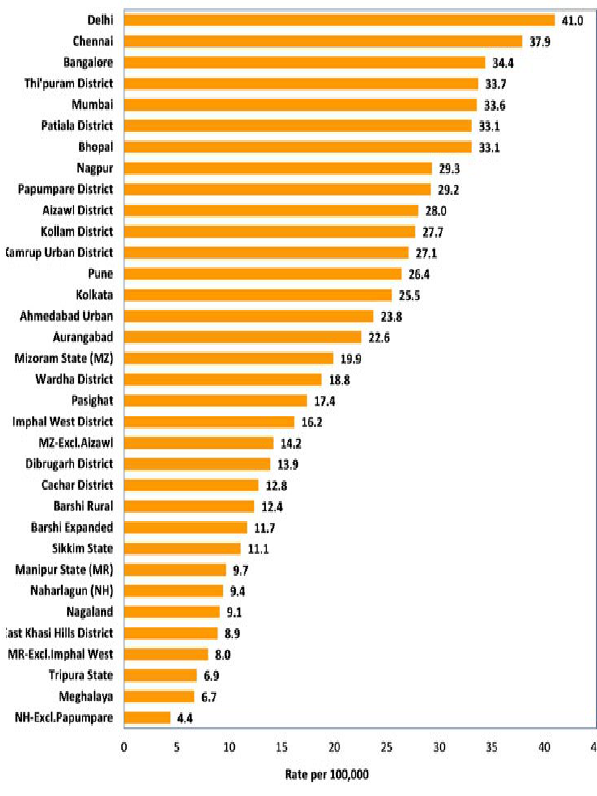
Table 1. Female Breast Cancer Incident Cases as per